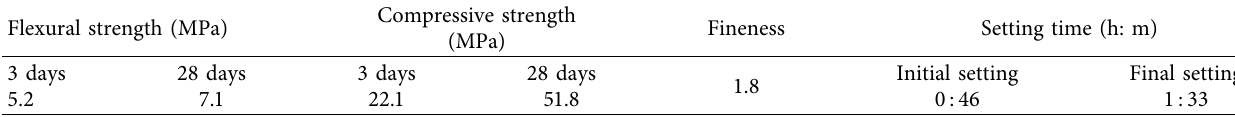
Table 1: Mechanical properties of Portland cement (MPa).